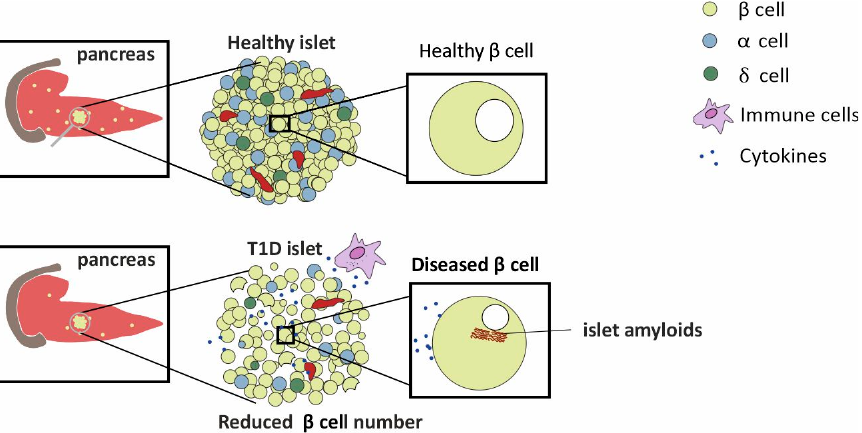
Figure 2. The difference in the number of β -cells in healthy and T1D islets is depicted. A diseased islet shows the presence of